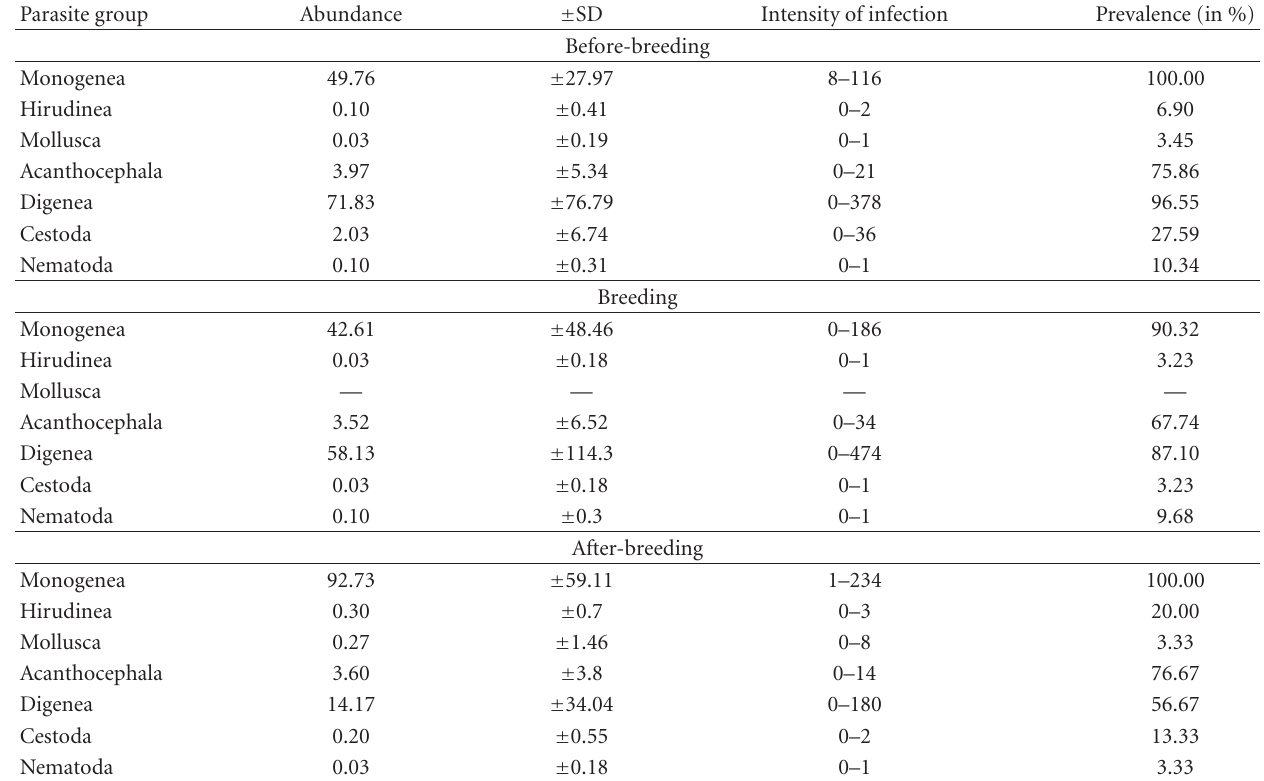
Table 3: Basic epidemiological characteristics: abundance (mean ± SD), intensity of infection (min-max), and prevalence (percentage of infected hosts) of all metazoan parasite